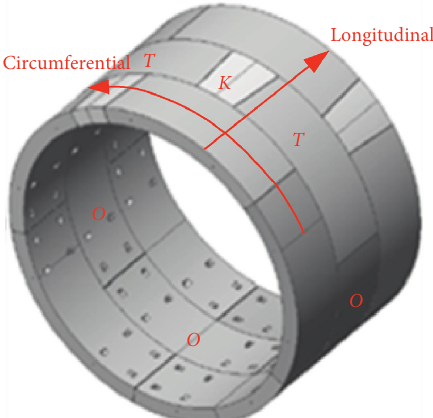
Figure 3: Staggered assembly form.